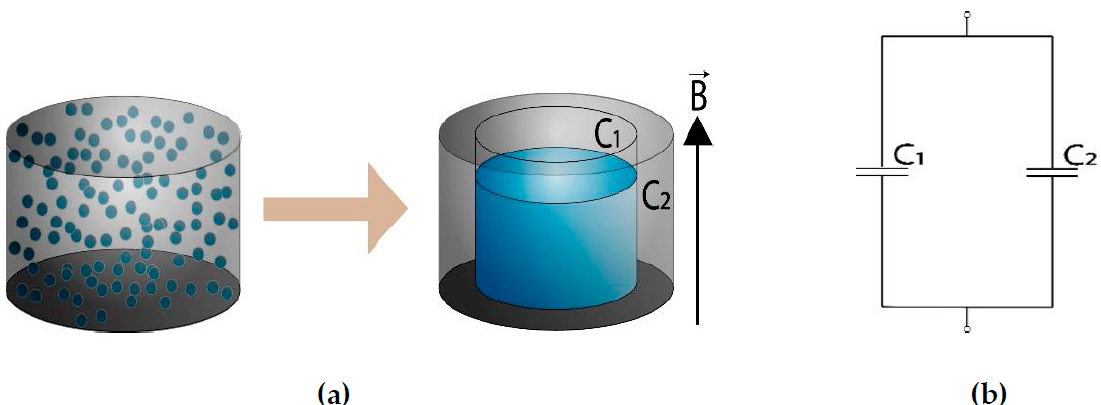
Figure 1. ( a ) Restructuring of the ferromagnetic filler in a magnetoactive elastomers (MAE) and ( b ) the corresponding equivalent circuit proposed in [12]. C 1 denotes the polymer capacitance over the compacted filler, while C 2 stands for the capacitance of the rest of the polymer matrix. The filler is assumed to be a perfect electrical conductor.